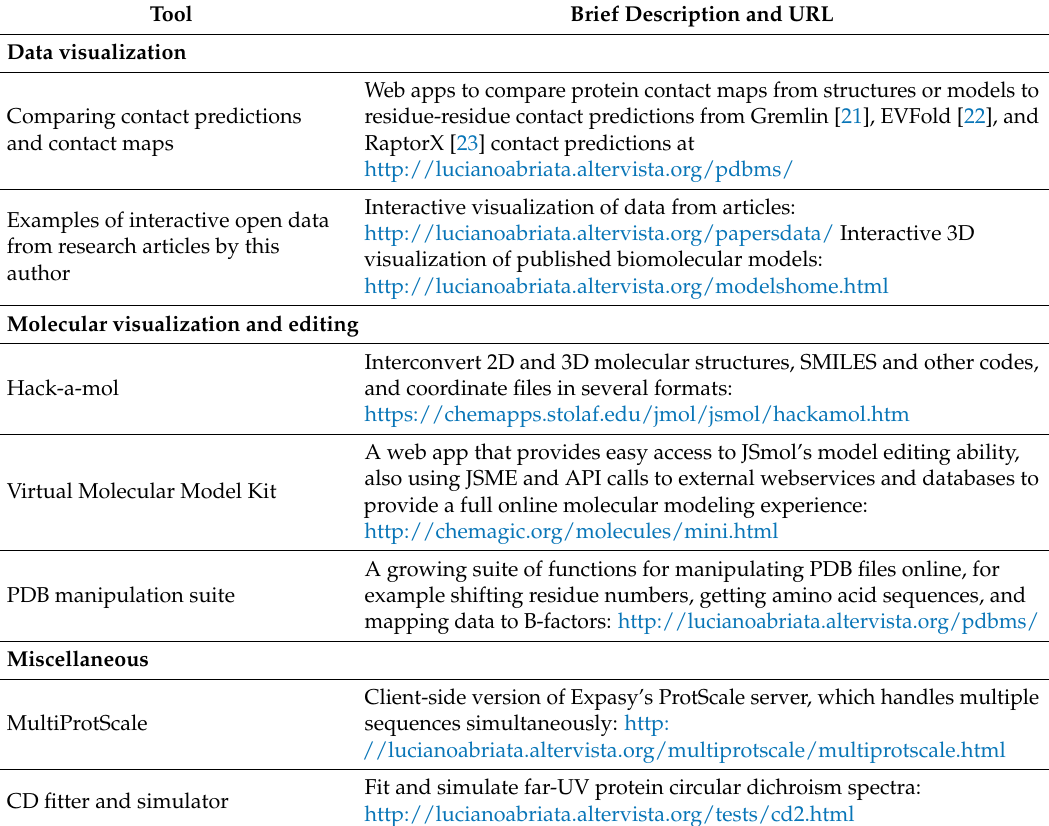
Table 2. Some unreferenced web apps of direct use in molecular biosciences, that rely entirely or largely on JavaScript.